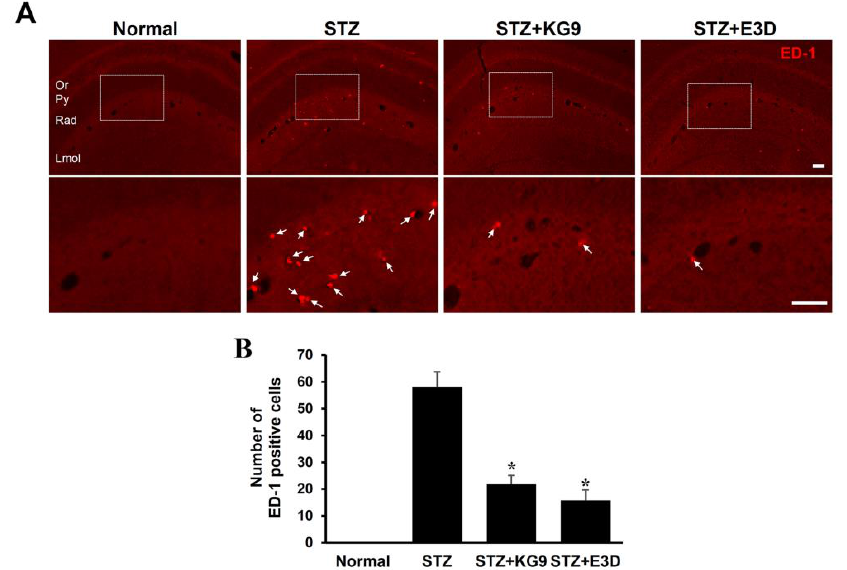
Figure 6. GS-KG9 and GS-E3D inhibit macrophage infiltration in the hippocampus of STZ-induced diabetic rats. Brain tissue from rats treated with GS-KG9 and GS-E3D (300 mg / kg) were prepared at 28 d after drug treatment. ( A ) Representative fluorescence photographs show that ED-1-labeled macrophages in hippocampal CA1 area. The bottom panels are higher magnification images of the box area in the upper panels. Arrows indicate ED-1-positive macrophages. Scale bar, 50 µ m. ( B ) Quantification of ED-1 positive cells in CA1. Data are presented as the mean ± SD. * p < 0.05 vs. STZ control ( n = 3 rats/group).